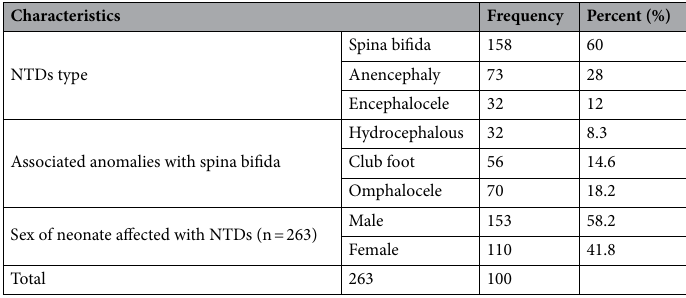
Table 3. Characteristics of the observed neural tube defects (n = 263).